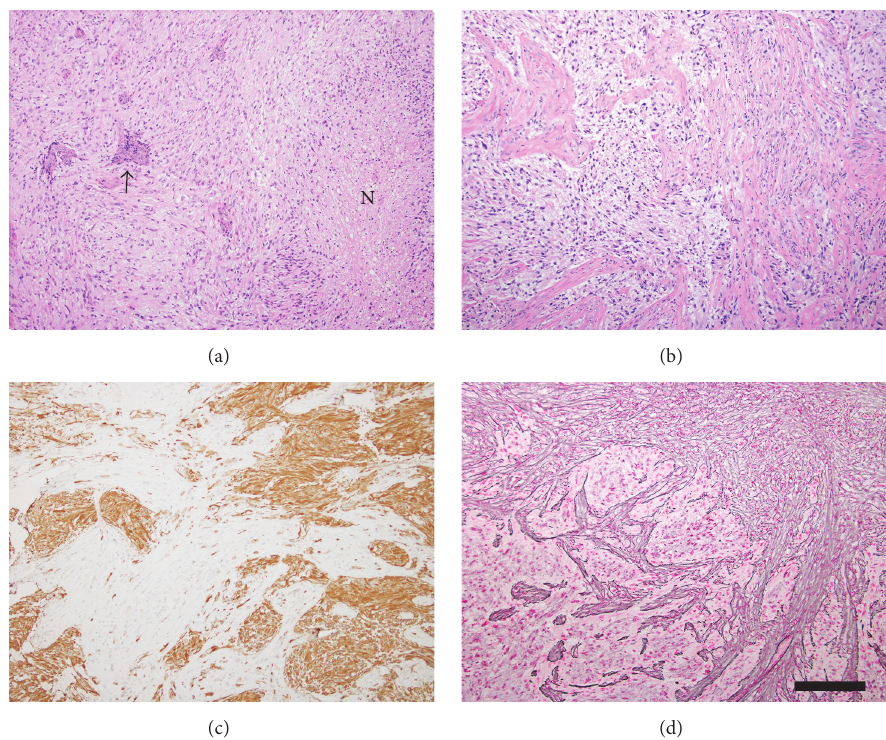
Figure 4: (a) The hematoxylin and eosin-stained histological sections showed an infiltrating glioma containing microvascular proliferation (arrow) and foci of necrosis surrounded by vaguely pseudopalisading tumor cells (“N”), diagnostic of glioblastoma. (b) Other areas showed a malignant mesenchymal component admixed with the glioblastoma. (c) The GFAP stain highlights the glial component and is negative in the mesenchymal component. (d) In contrast, the reticulin stain demonstrates extensive pericellular deposition of collagen fibers in the mesenchymal component only and is negative in the glial component. These findings support the diagnosis of gliosarcoma (all images at 100x magnification; scale bar = 300 𝜇